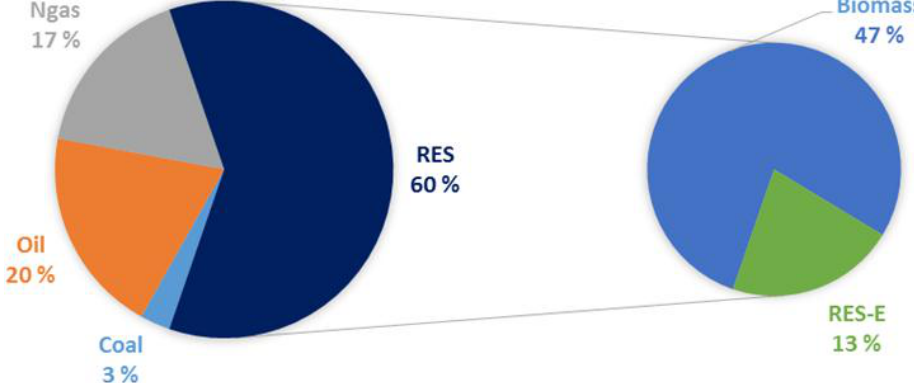
Figure 22. Fuel consumption in the Italian scenario with 60% RES.